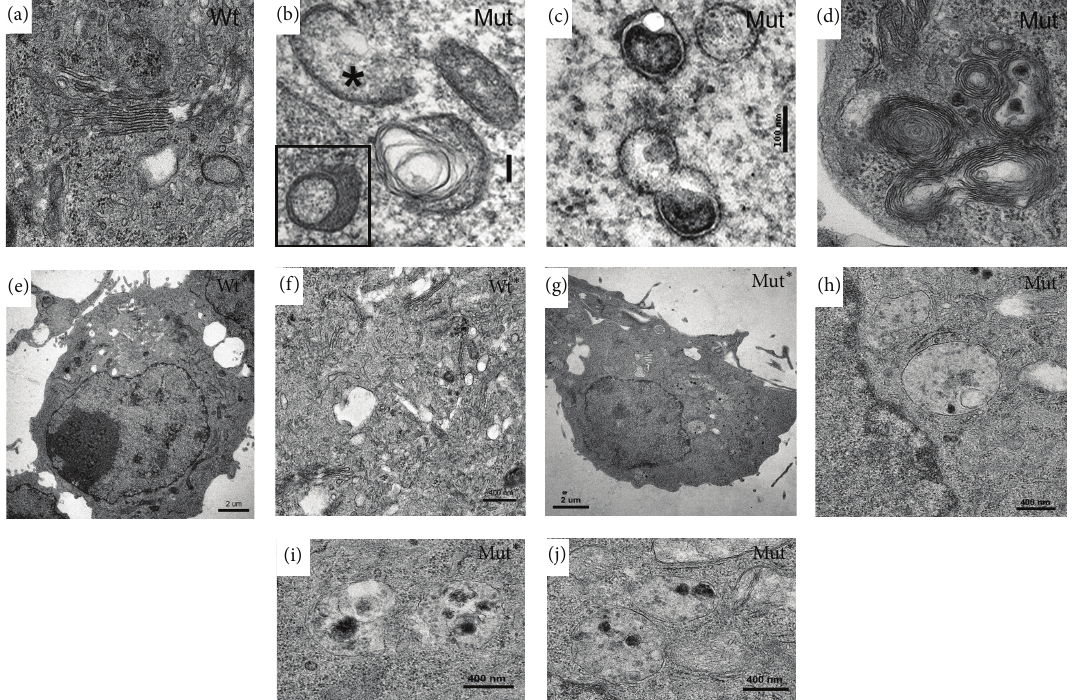
Figure 6: Ultrastructural markers of autophagy with Mut-PrP expression. Transmission electron micrographs of transiently transfected COS-7 cells ((a)–(d)) and stably transfected N2a cells ((e)–(j)). TEM of COS-7 cells expressing Wt (a) or Mut- ((b)–(d)) PrP for 24 h. Normal appearing ultrastructure present in cells expressing Wt-PrP (a), and abnormal membranes characteristic of isolation membranes ((b), asterisk), double membrane autophagosomes (c), and myelinoid (multilamellar) bodies (d) were evident in the majority of cell sections sampled from Mut-PrP expressing cells. (e)–(j) Mouse neuroblastoma N2a cells stably expressing Wt-PrP ((e)–(f)) or Mut-PrP ((g)–(j)). Mut-PrP expressing cells displayed an accumulation of multivesicular bodies and autophagy-related structures consistent with late stage autophagosomes and/or autolysosomes. These structures were largely absent in cells expressing